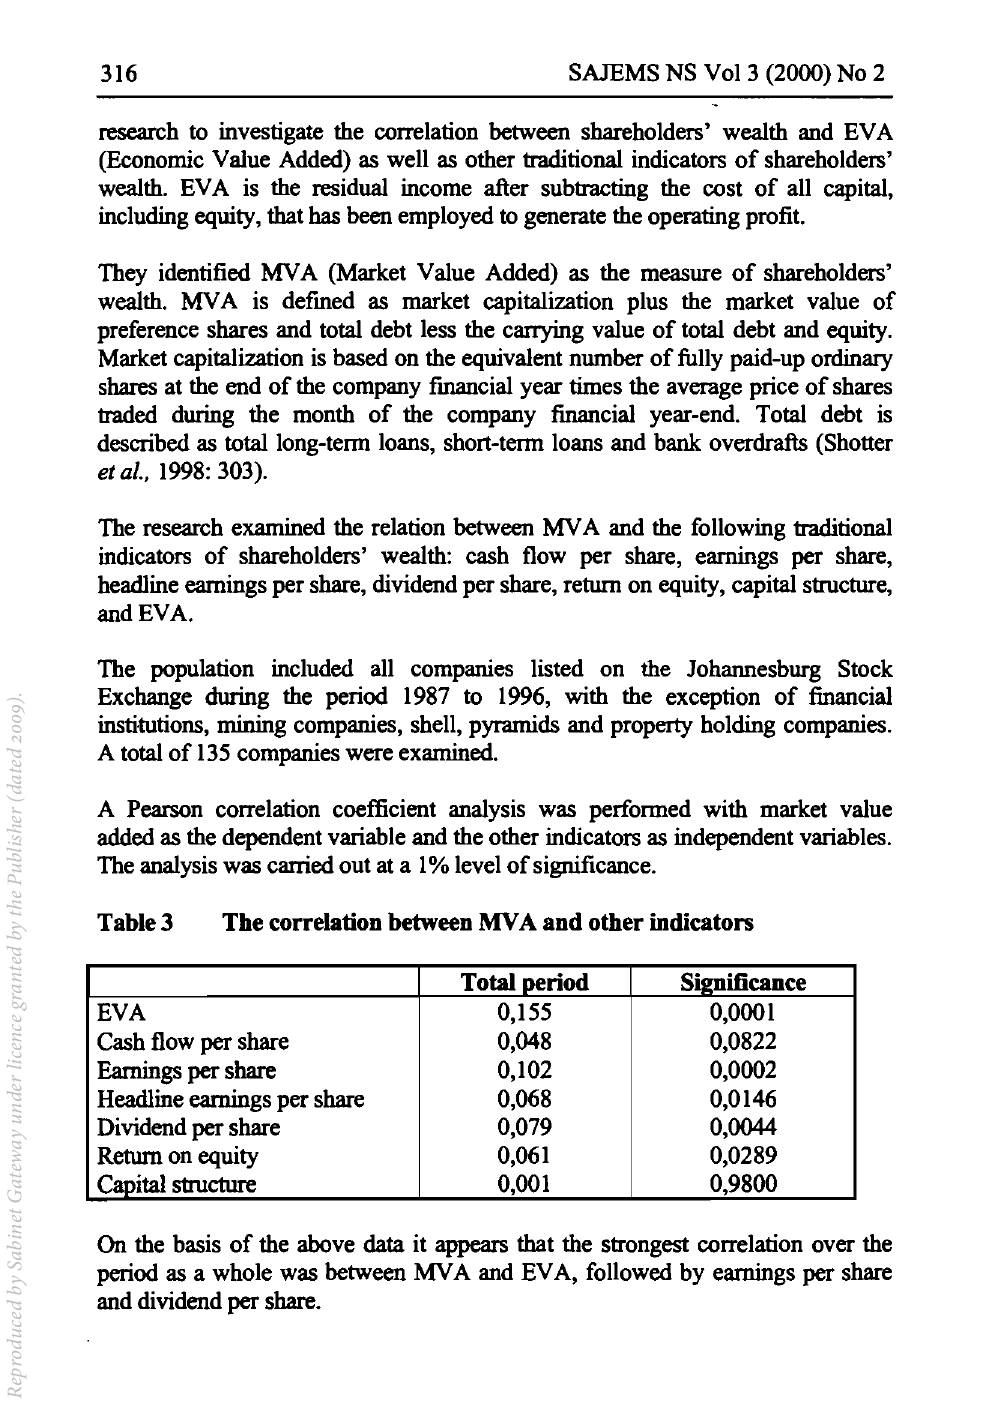
The correlation between MV A and other